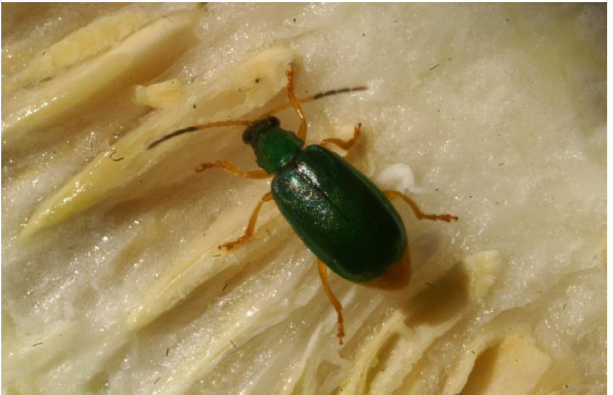
Figure 1. Diabroticite beetle of the species Diabrotica dissimilis Jacoby feeding on the seeds of an open fruit from wild, bitter Cucurbita okeechobeensis ssp. martinezii (L.H. Bailey). This plant species of the family Cucurbitaceae is native to Veracruz, Mexico (Photo: A.